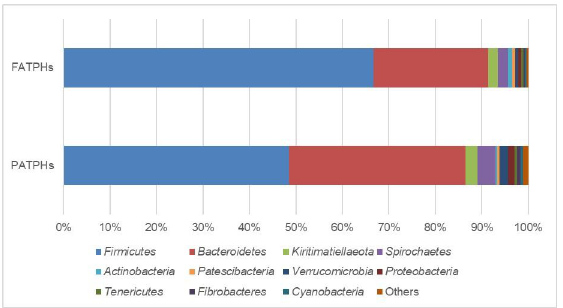
Fig 2. Top relative abundances of phyla ranked by -1 order of magnitude and higher based on the FATPHs with relative abundances of the corresponding phyla in the PATPHs shown. The relative abundances of the rest phyla were grouped as